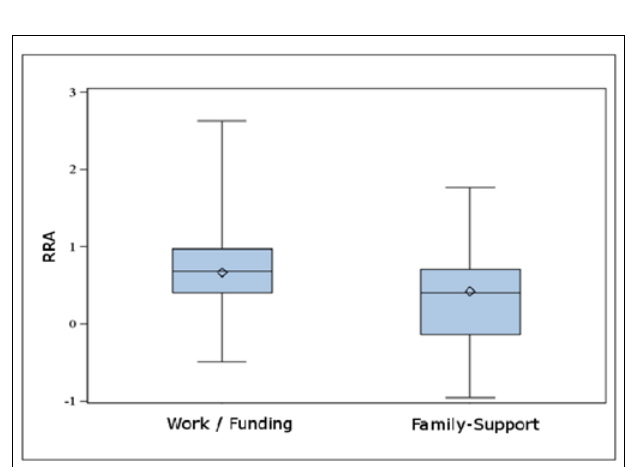
Thus, three subjects had to be excluded from the matrix game due to inconsistencies in their switch behavior (step back). In six other cases of the high-stake sequential game, no reasonable values of the switching point could be calculated.